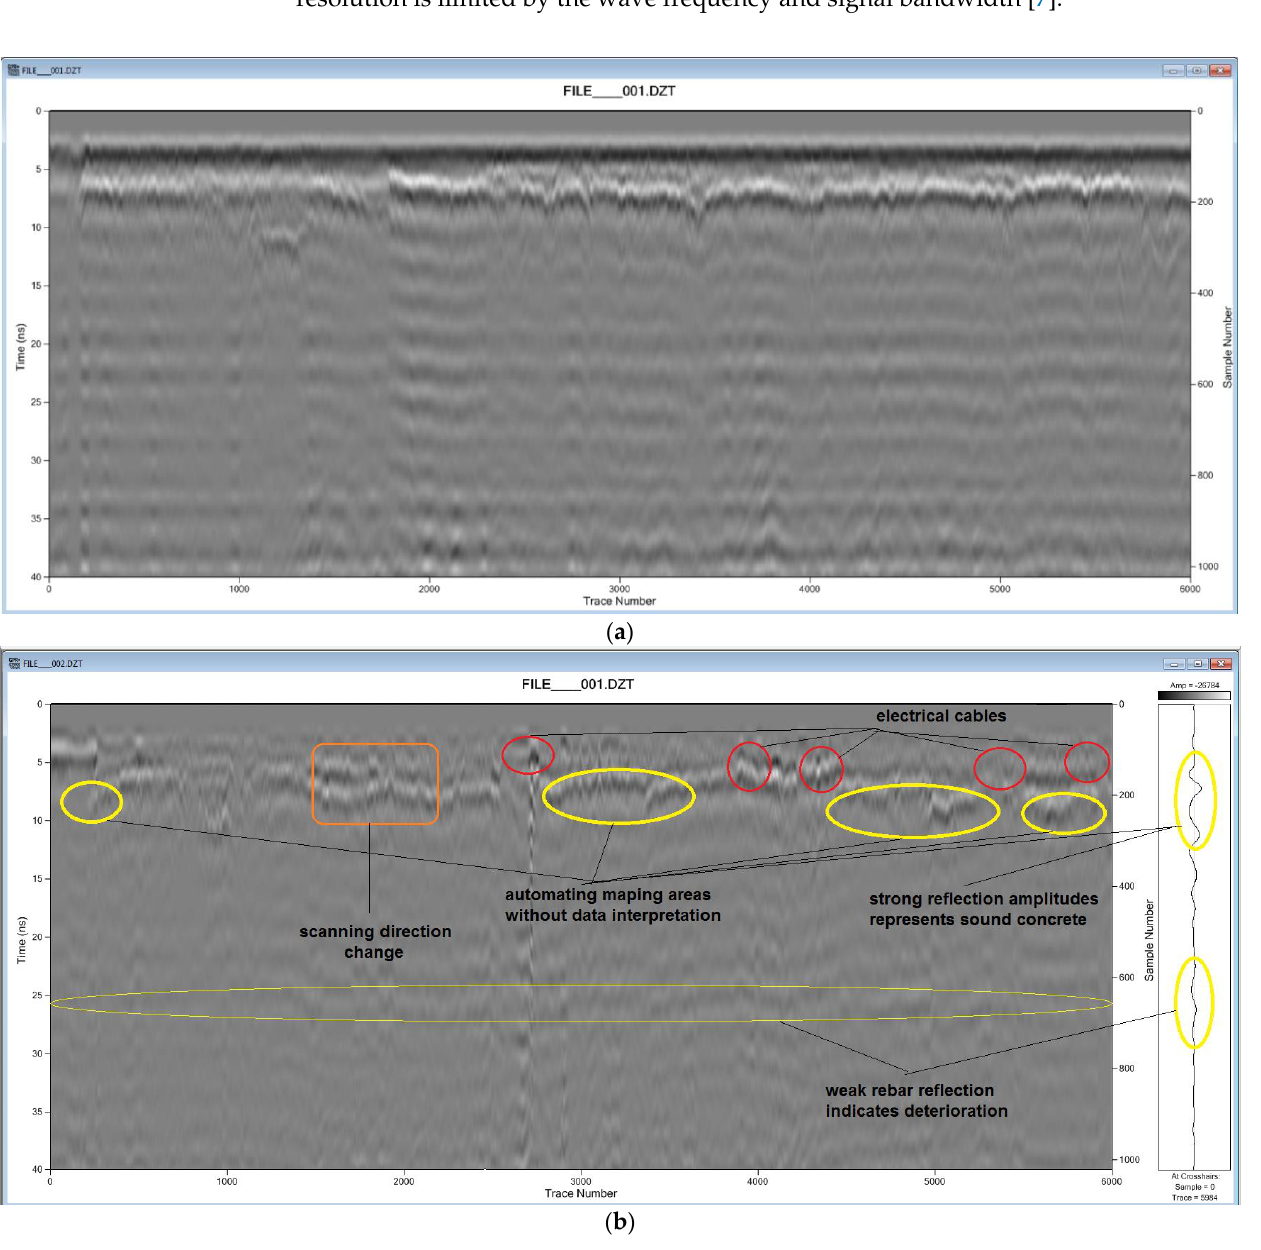
Figure 4. ( a ) GPR raw data containing a profile with the air wave, ( b ) GPR radargrams of surveyed zone — parallel traces and partition for data interpretation.